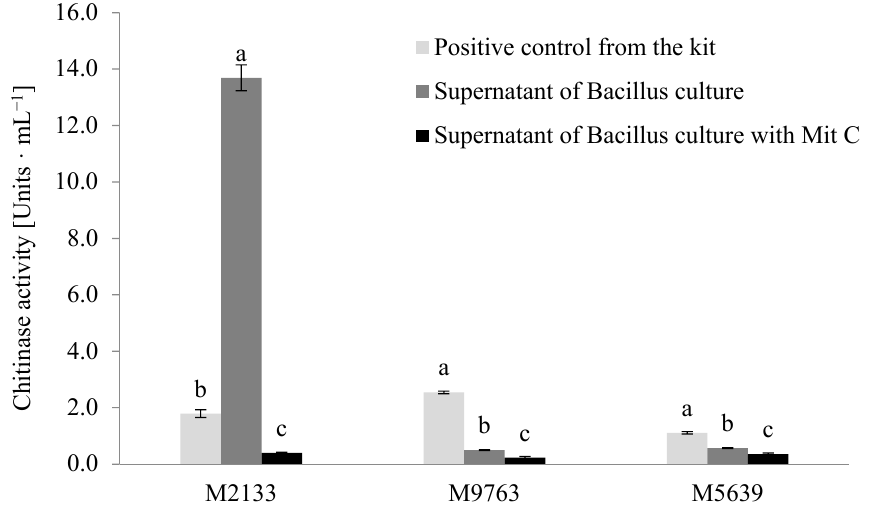
Figure 6. The activity of the chitinase produced by Bacillus sp.; positive control provided with the kit is represented by a light grey bar; the results obtained for the bacterial samples without an induction agent are marked as a dark grey bar; the activity of the enzyme in bacterial samples, in which the induction of prophage was provoked by mitomycin C, are marked as a black bar; names: M2133 and M9763 indicate substrates used for detection of exochitinase activities ( β -N- acetylglucosaminidase and chitobiosidase, respectively) whereas M5639 indicate the substrate used for endochitinase activity; the presented results are mean values from three independent experiments. Error bars indicate SD (standard deviation) and statistical significance was tested by the one-way analysis of variance (ANOVA) followed by the Tuckey post-hoc test at p ≤ 0.05; bars topped by the same letter (a, b or c) do not differ significantly.